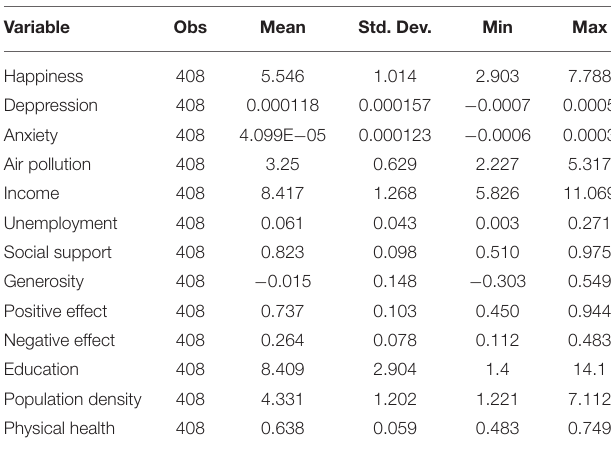
TABLE 2 | Descriptive statistics of full